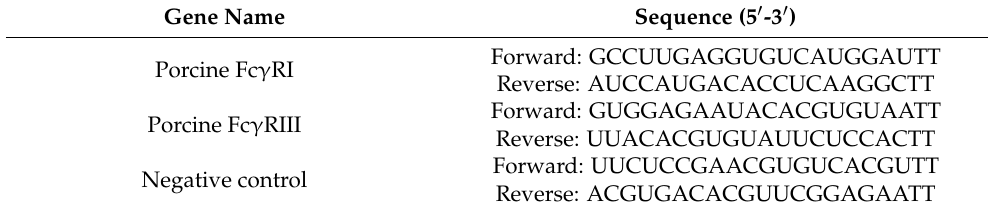
Table 3. The sequences of siRNAs.